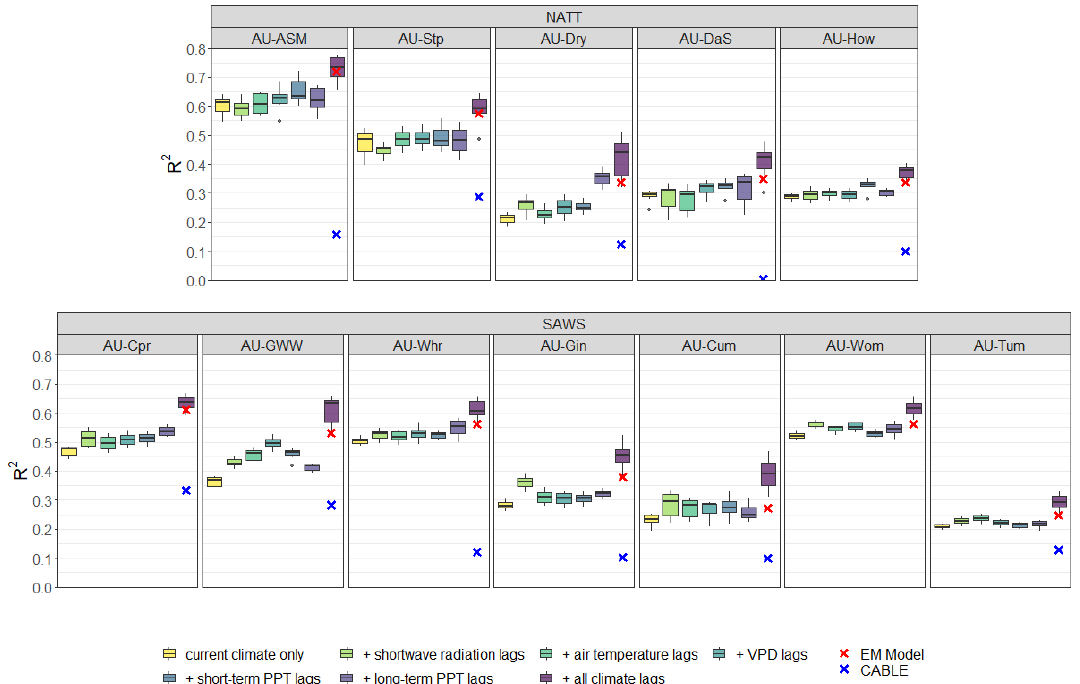
Figure 5. R 2 values for seven different models of k -means clustering plus regression predicting NEE at the flux sites, split by the two vegetation groups. “Current climate” is the k -means model that only considers concurrent environmental observations for predicting NEE. Each of the five lagged environmental predictors are then introduced separately; “+ all climate lags” is the model where every lagged environmental variable is included and hence utilises exactly the same predictors as the EM SAM model. Boxplots indicate the distribution of the R 2 values when these models are run for between two and eight clusters each. The EM SAM model R 2 value is indicated by a red cross, and the R 2 for a PFT-parameterised TBM (CABLE) is shown with a blue cross. Note that AU-Wom had no available CABLE output. Sites are ordered from left to right by ascending mean annual precipitation within each vegetation